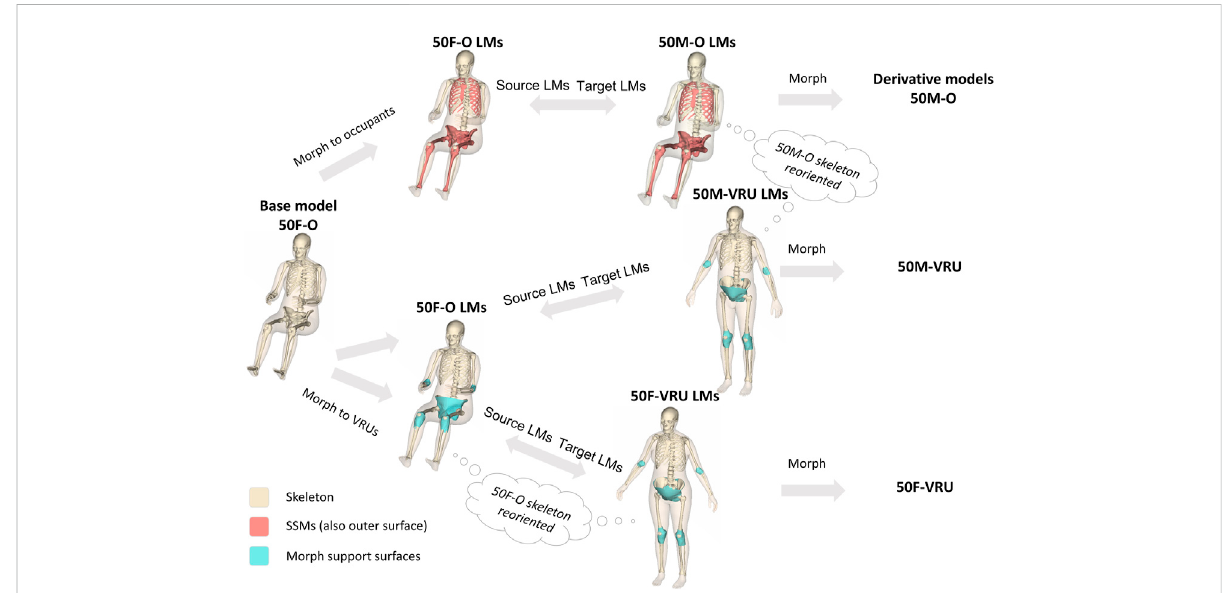
FIGURE 3 Morphing work fl ow to create the derivative models. The brown surfaces (including the beige outer surface) represent body parts for which SSMs exist. The beige skeletal surfaces represent body parts that are scaled in other ways or that are repositioned. Blue surfaces represent support surfaces that are pre-morphed and adjusted to guide the morphing in joints that experience large rotations during morphing (LM: